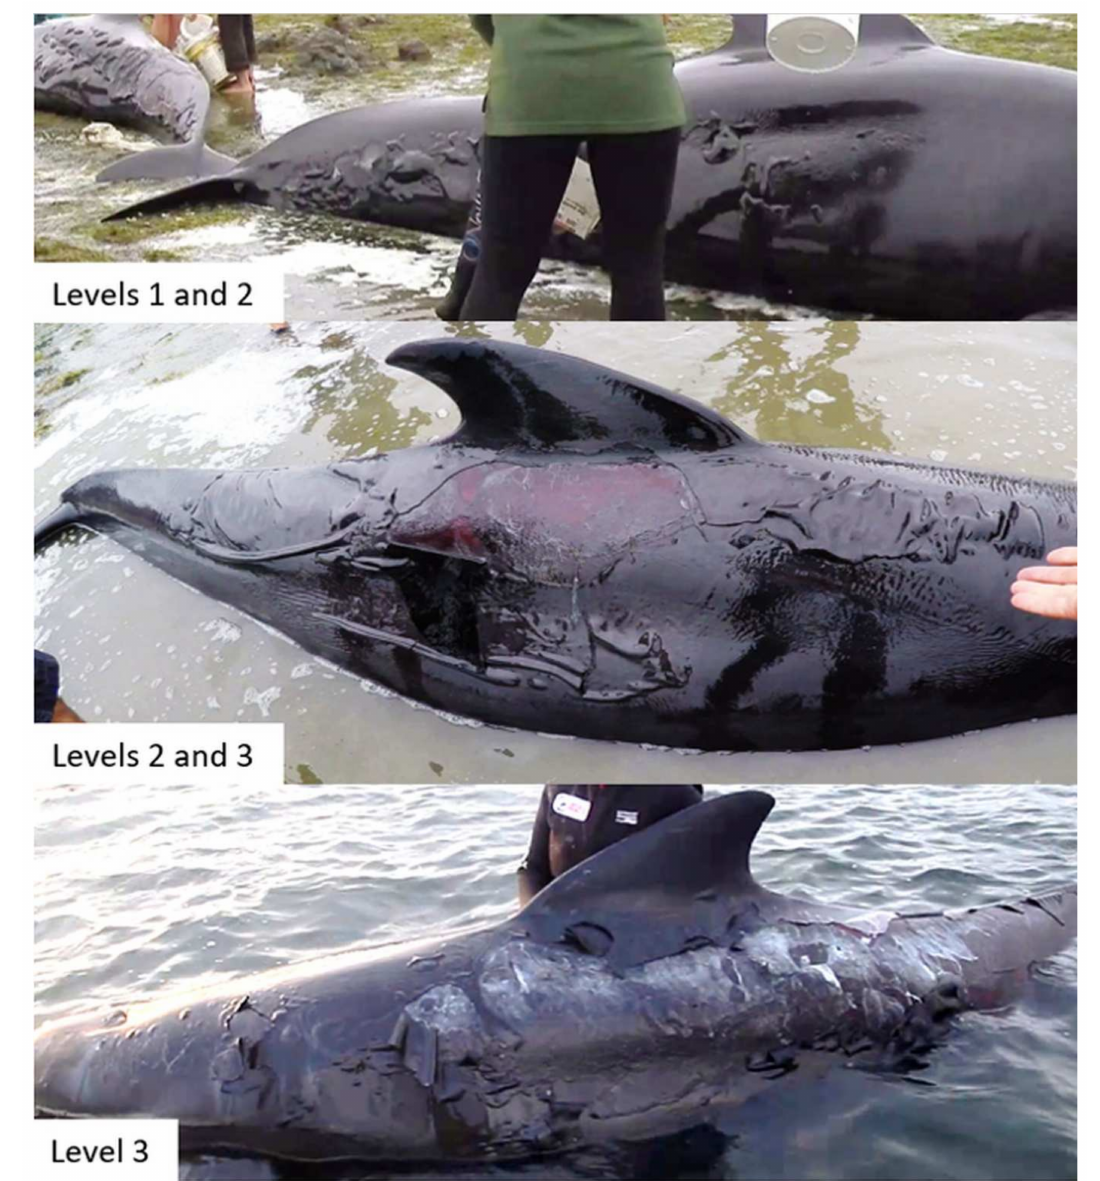
Figure 2. Level of skin blistering observed in individual focal animals. ( 1 ) Dermal necrosis and ( 2 ) bullae development on two individuals (top), ( 2 ) bullae development and ( 3 ) recent dermo- epidermal clefting with ulceration (middle), ( 3 ) dermo-epidermal clefting with ulceration two days after initial stranding (bottom). Photos credits: Kyle Mulinder (top and middle) and Project Jonah NZ